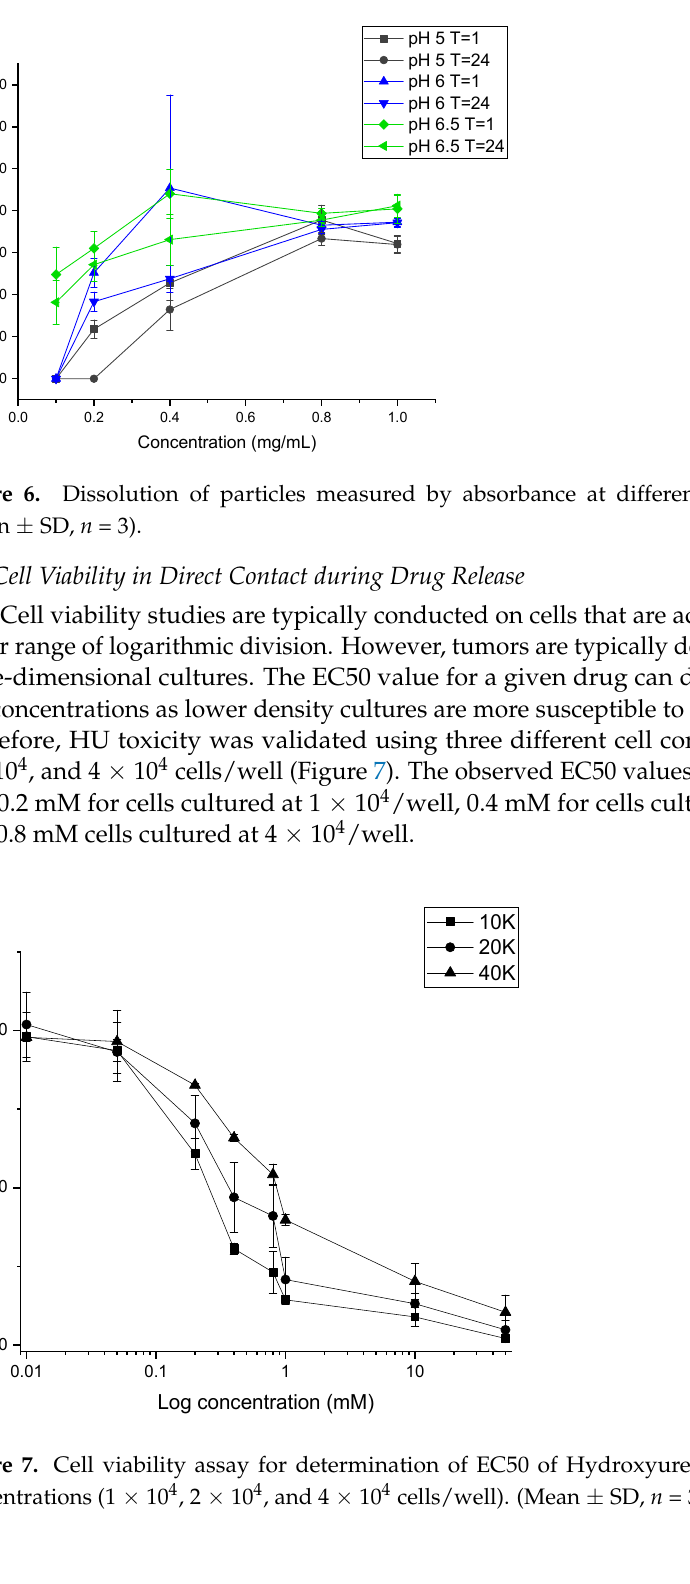
Figure 5. Microscope image of 1 mg/mL particles in acidified DMEM cell media, incubated in 37 °C at different pH; pH 1 ( A ), pH 2 ( B ), pH 3 ( C ), pH 4 ( D ), pH 5 ( E ), and pH 6.5 ( F ) at T = 0 h.